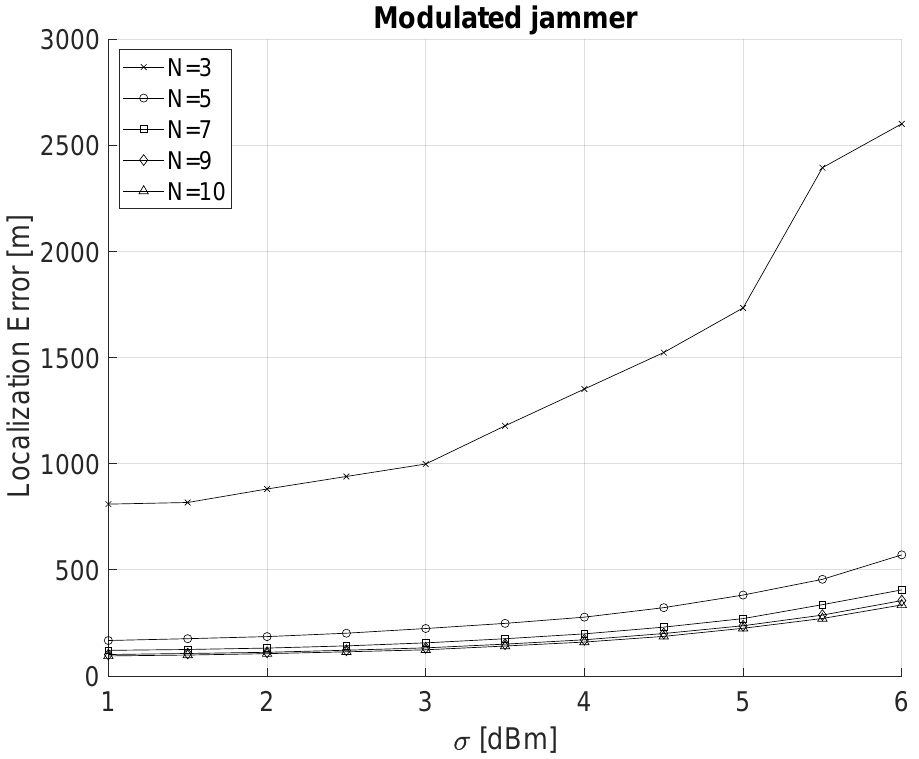
Figure 5. Localization of a power-modulated jammer as a function of σ (1 dBm ≤ σ ≤ 6 dBm) and the number N of sensing nodes (3 ≤ N ≤